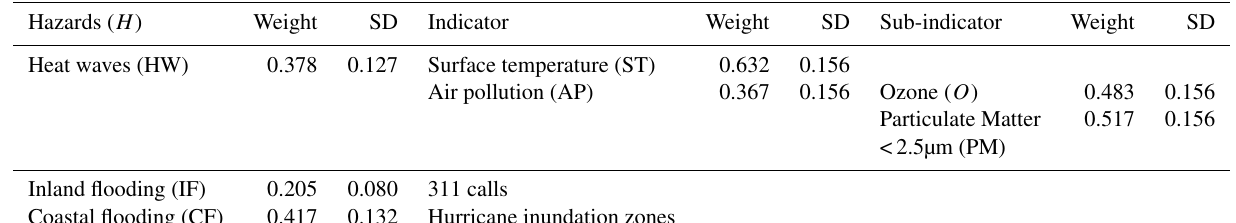
Table 1. Hazard indicators selected, and weights derived from the survey with standard deviations (SDs). (The SDs are equal due to the weighting method which required the allocation of 100 points amongst the sub-indicators indices.)